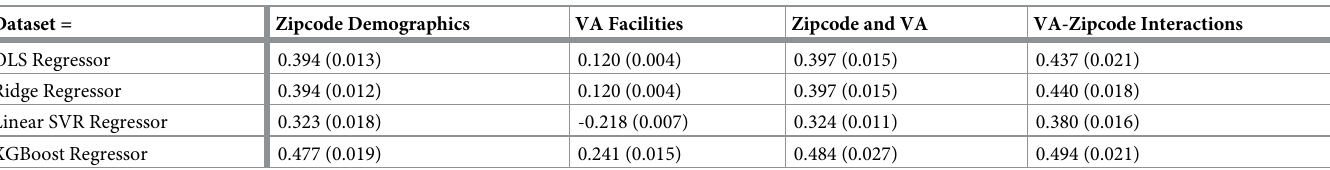
Table 3. ML model R 2 performance metrics over all